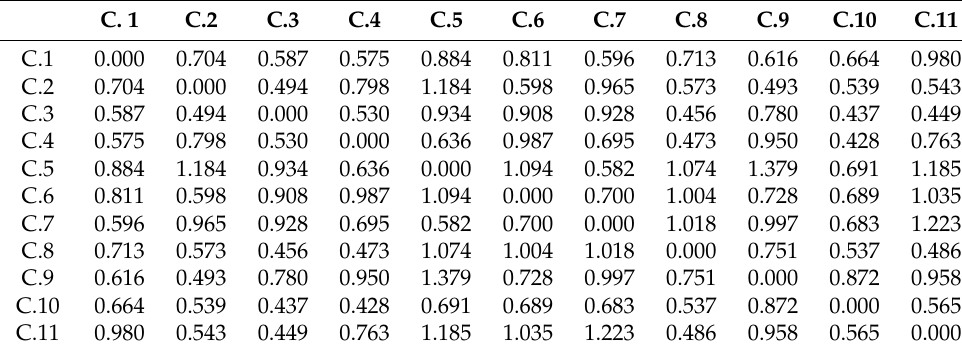
Table 6. The average cluster